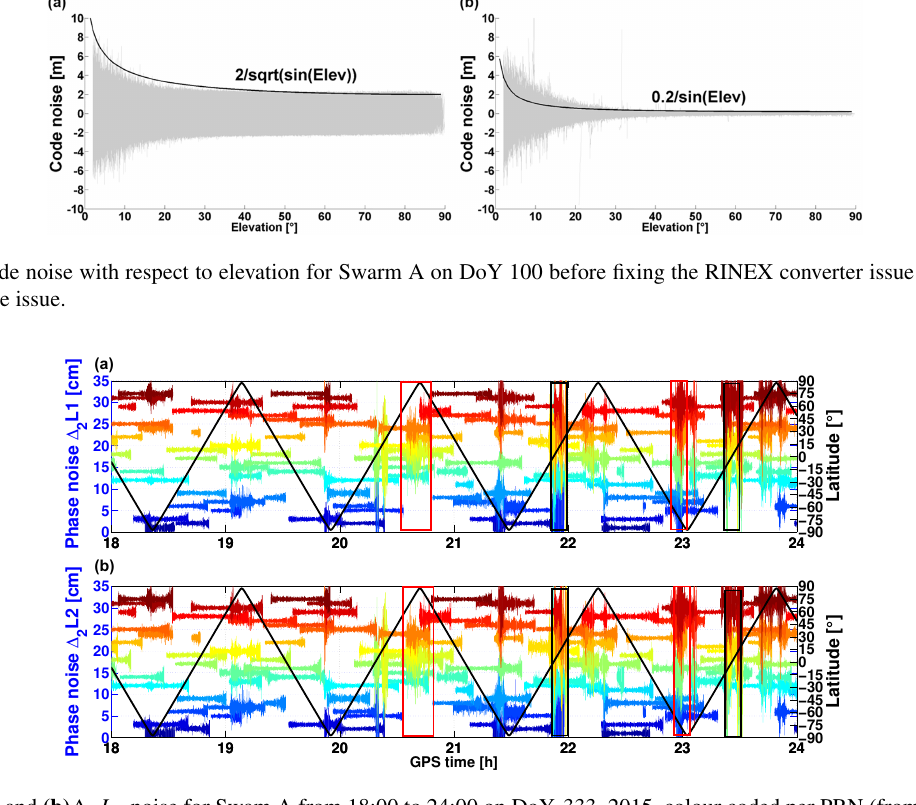
Figure 3. (a) (cid:49) 2 L 1 and (b) (cid:49) 2 L 2 noise for Swam A from 18:00 to 24:00 on DoY, 333, 2015, colour coded per PRN (from blue PRN1 to red PRN 32). The time series are intentionally shifted by PRN × 1cm. The local time is 08:30 for the descending arc and 20:30 for the ascending arc. The right legend shows the geographic